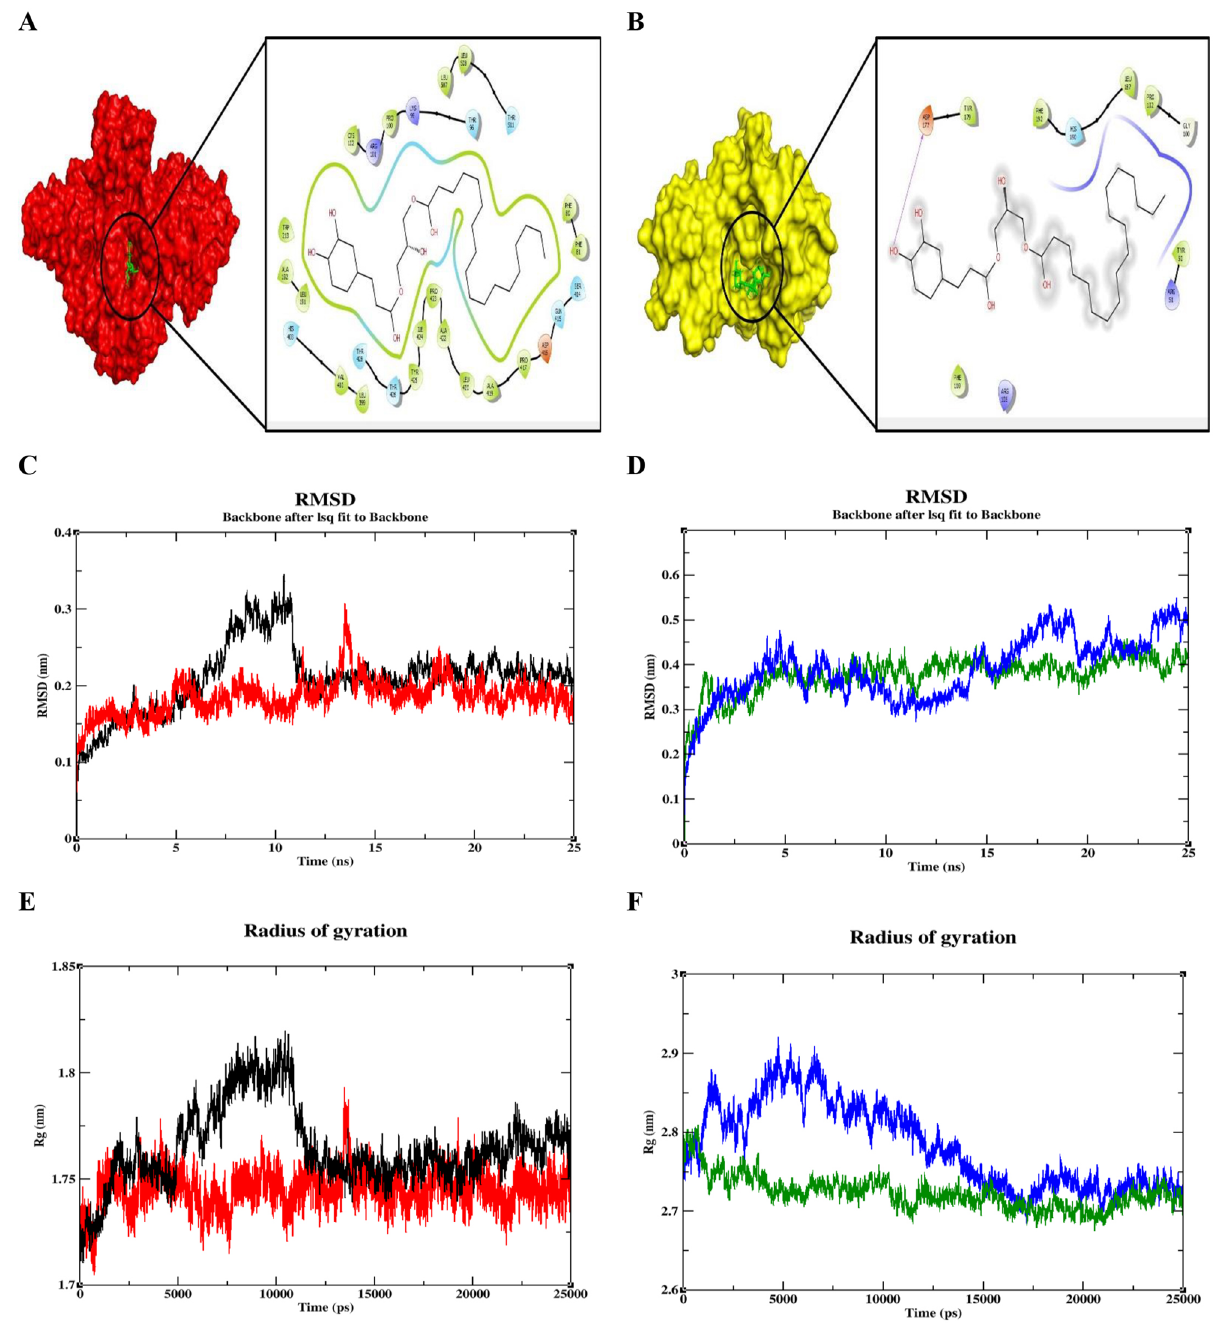
Figure 5. Molecular docking analysis of C 1 (green) with MMP2 (red) ( A ) and MMP9 (yellow) ( B ) (Schrödinger, NY, 2018) indicate binding of C 1 to (> 20 aminoacids of) MMP2-PEX region and (> 10 aminoacids of) MMP9. Molecular Dynamic simulations for C 1 was performed and the stability with MMP2 ( C ) and MMP9 ( D ) was ascertained for 25 ns determine the extent of stability of C 1 -target complex. Radius of Gyrations (Rg) was carried out to predict the levels of compactness for C 1 -target complex (MMP2) ( E ) and MMP9 ( F ). Color scheme: native MMP2 (Black); C 1 -MMP2 complex (red); native MMP9 (blue) and C 1 -MMP9 complex